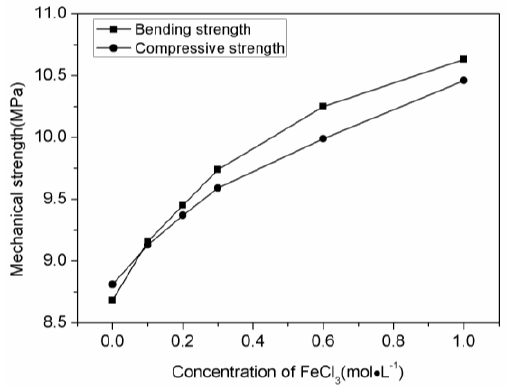
Figure 8. The mechanical strength of α-Fe/Fe 3 C/woodceramic nanocomposites as a function of concentration of FeCl 3 .